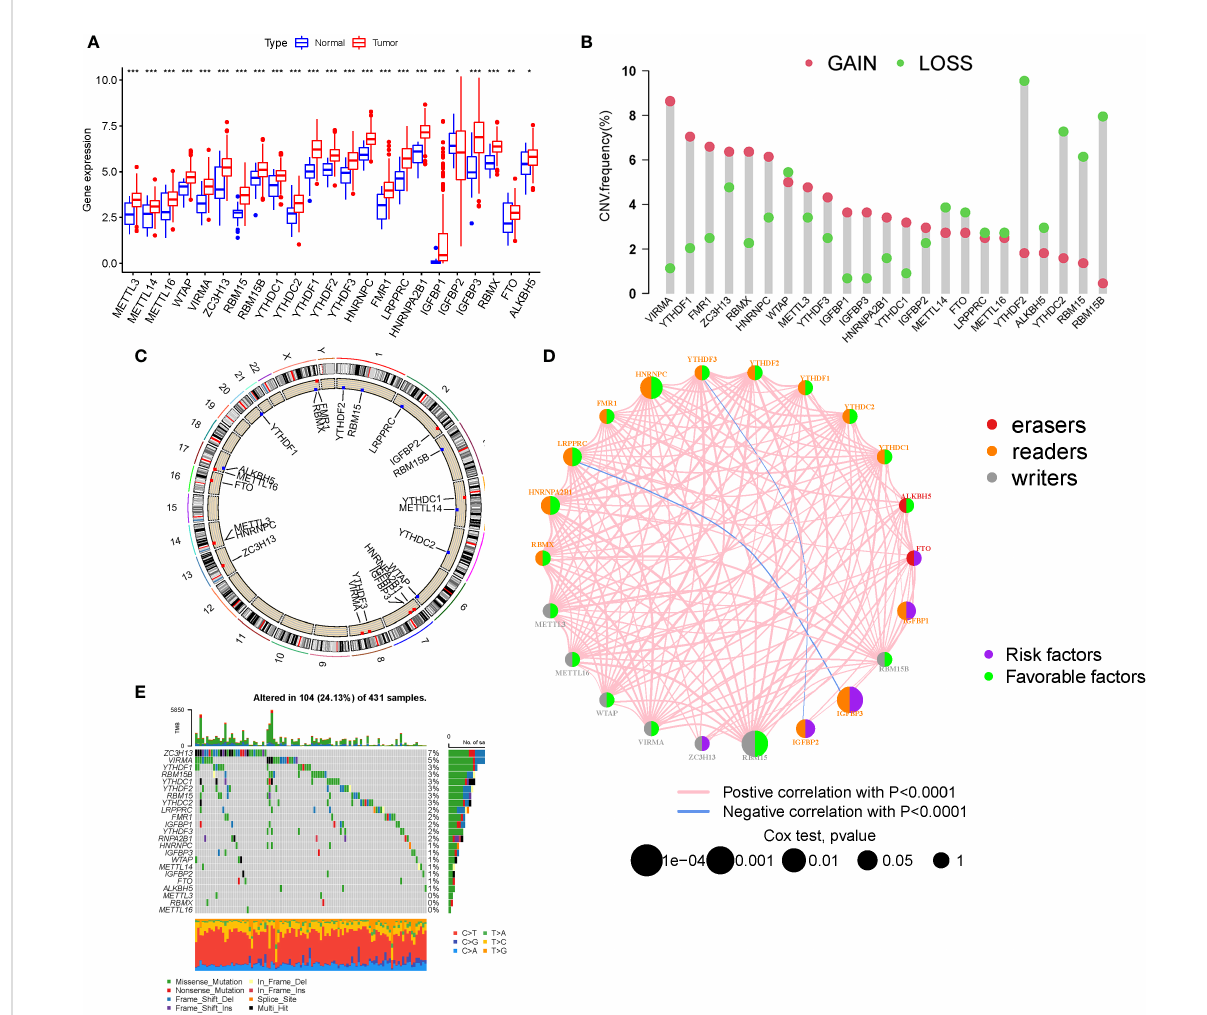
FIGURE 1 Landscape of genetic and expression variation. (A) The expression of m6A regulators. (B) The CNV variation frequency. (C) CNV Analysis (M6a shows a signi fi cant association with CNV in STAD). (D) The interaction between m6A regulators (The m6A regulatory network is a study of the expression correlation and prognostic importance of the 24 m6A regulators in STAD patients). (E) Waterfall plot of TMB (the frequency of m6A regulator mutations was lower than 7%). (*P < 0.05; **P < 0.01; ***P <